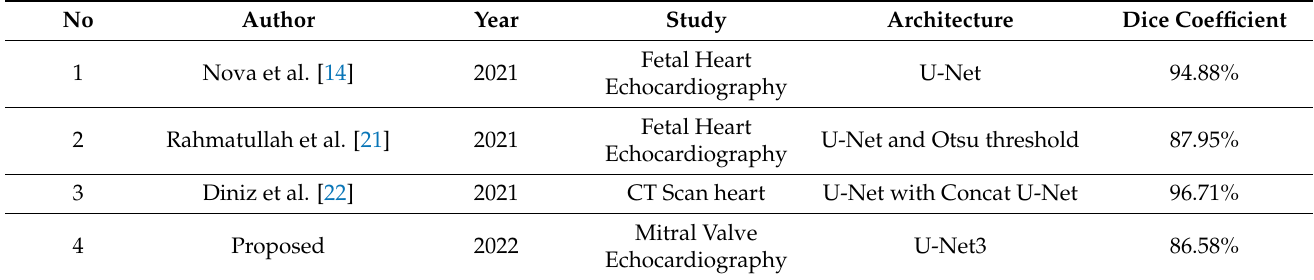
Table 9. Comparison of other methods with different data for